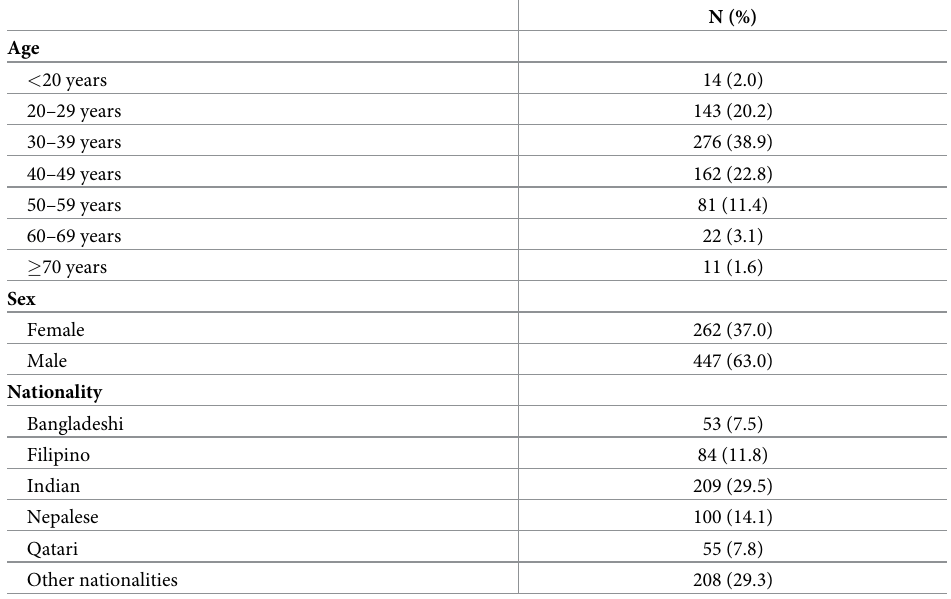
Table 1. Demographic characteristics of the sample that included 709 individuals who were tested for SARS- CoV-2 antibodies using the BioMedomics COVID-19 IgM/IgG Rapid Test and the Roche Elecsys Anti-SARS- CoV-2